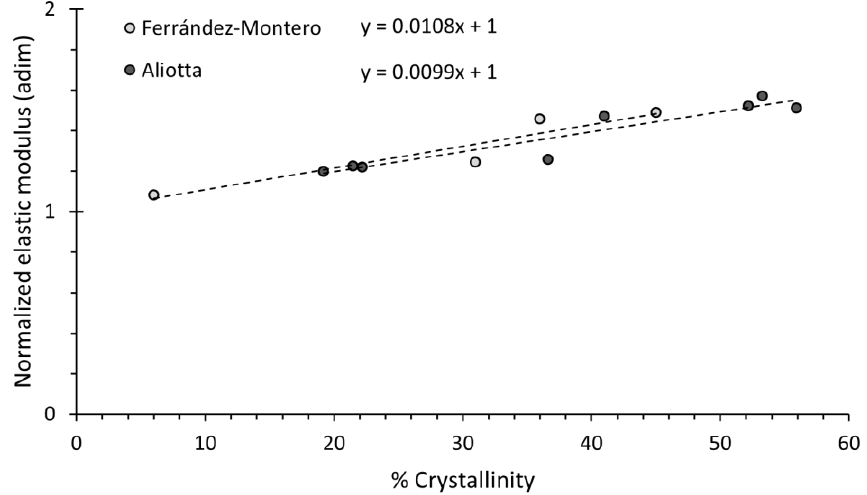
Figure 9. Normalised values of the elastic modulus for PLA materials and their evolution with the crystallinity percentage.